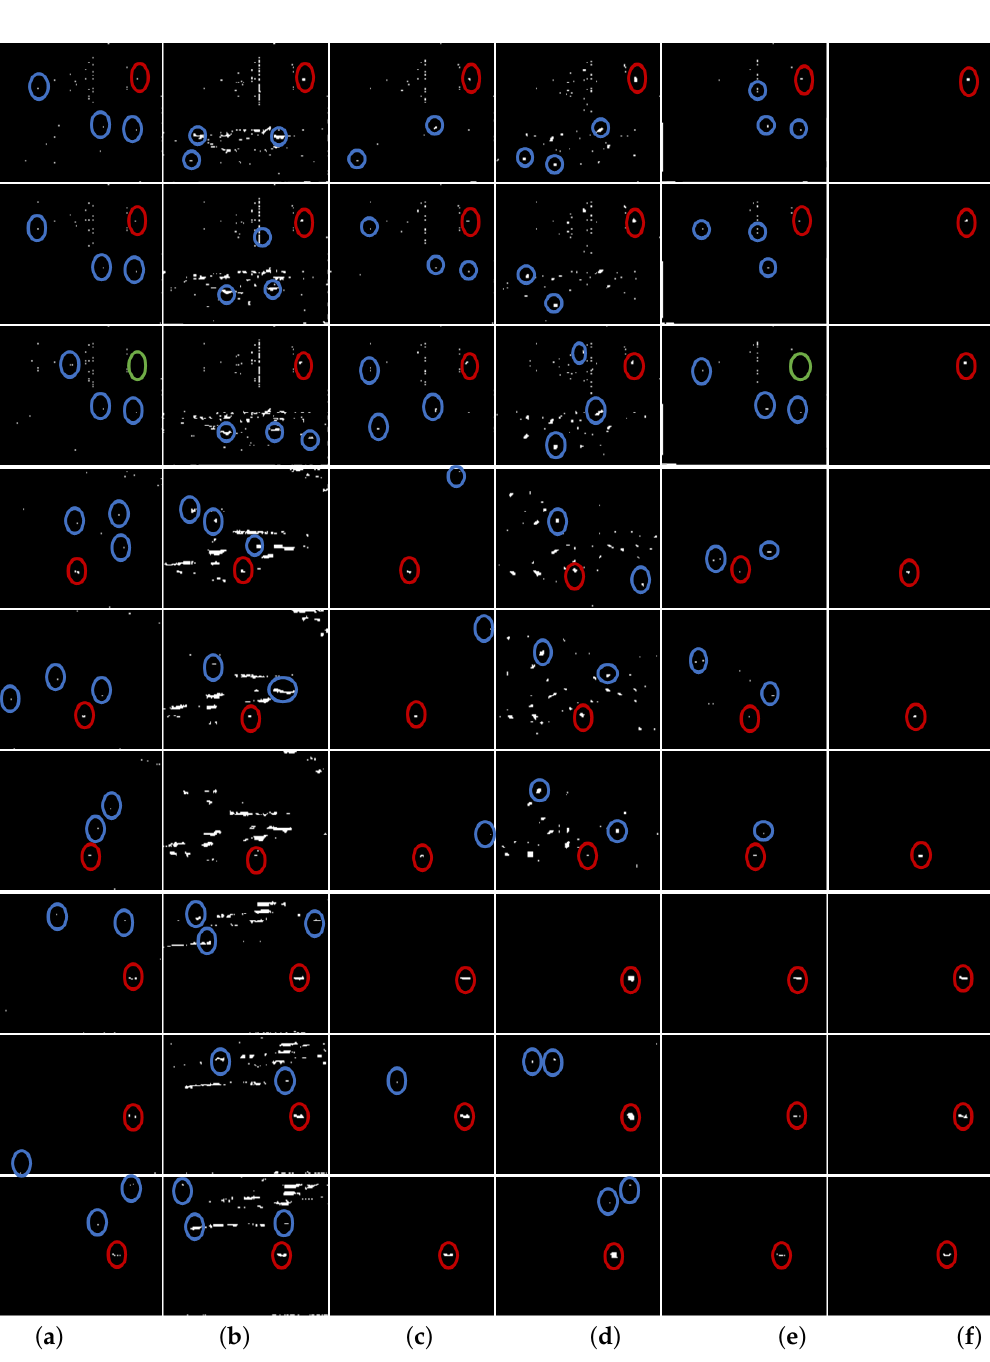
Figure 7. Visual illustration of the results of the proposed method and other existing methods. The first three rows, the middle three rows, and the last three rows illustrate the results of the proposed method and other existing methods on Sequence 1, Sequences 2 and Sequence 3 respectively. ( a ) denotes the detection results of MM method, ( b ) denotes the detection results of TH method, ( c ) denotes the detection results of IPI model, ( d ) denotes the detection results of MPC method, ( e ) denotes the detection results of WLD method, and ( f ) denotes the detection results of the proposed